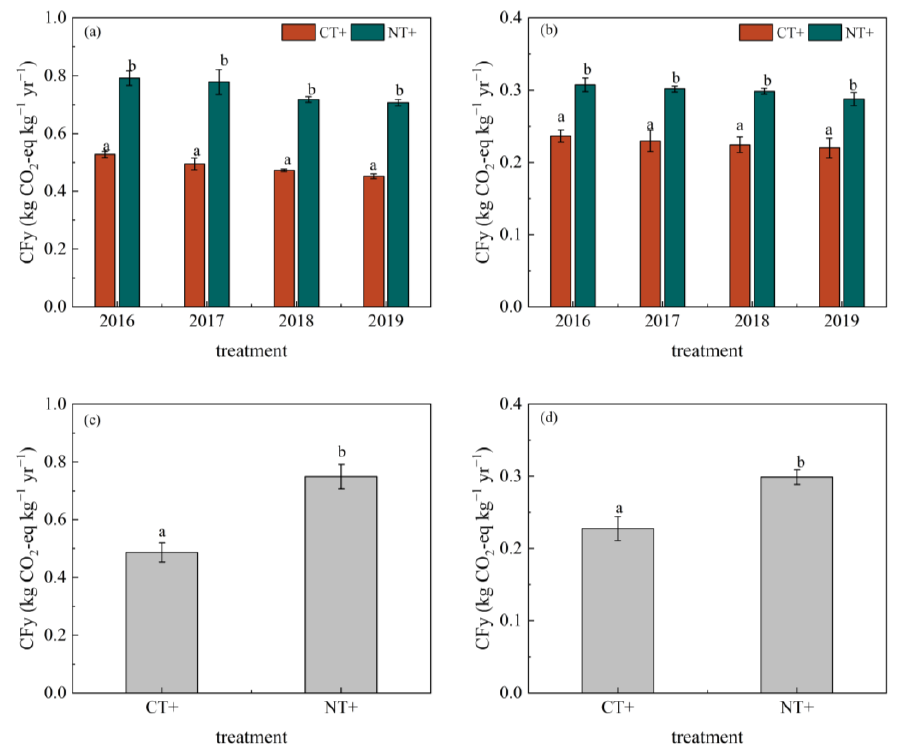
Figure 6. The CFy of wheat production from 2016 to 2019 at ( a ) Wudi and ( b ) Yucheng; four-year average CFy at ( c ) Wudi and ( d ) Yucheng sites. CT+ is crop residue incorporated into the soil with plough tillage, NT+ is crop residue mulching soil with no-till. The small letters indicate the significant differences across treatments at p < 0.05 level.